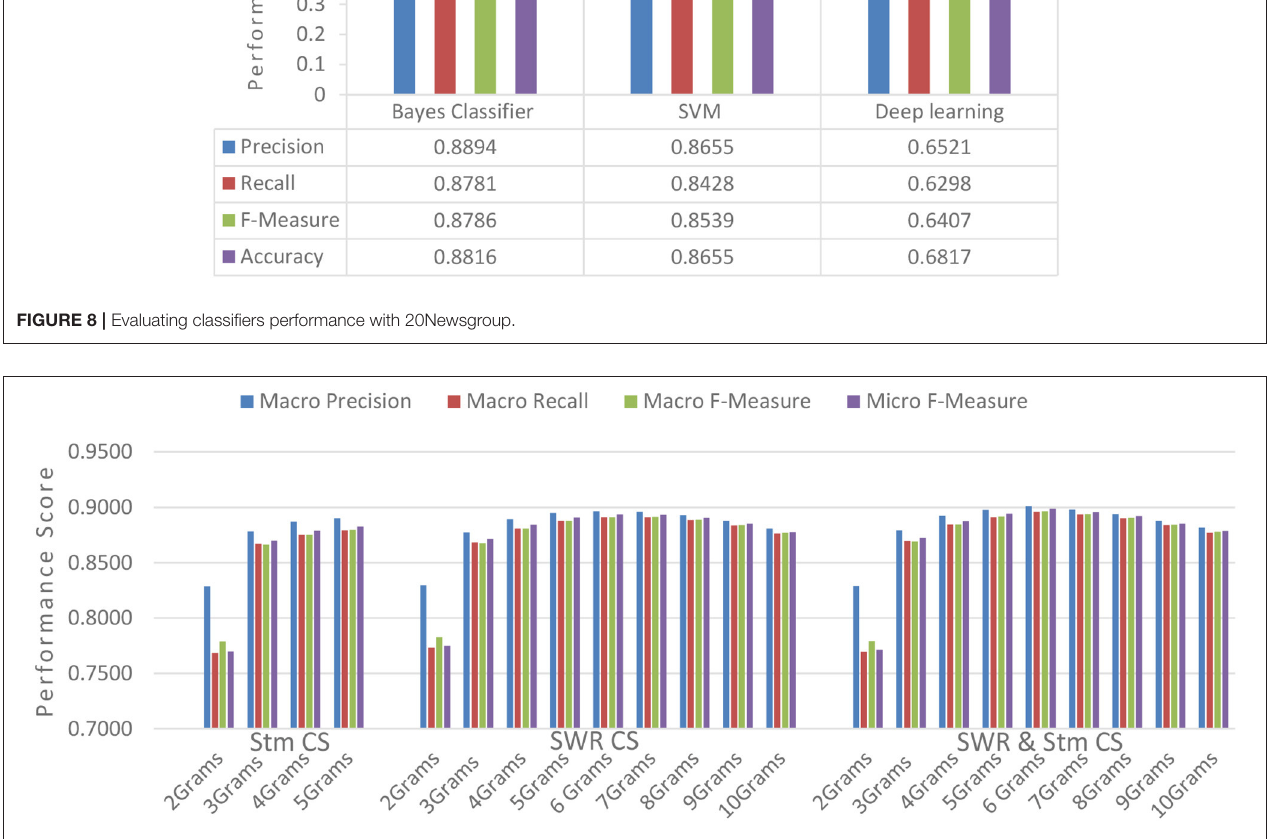
FIGURE 9 | Evaluating preprocessing techniques with